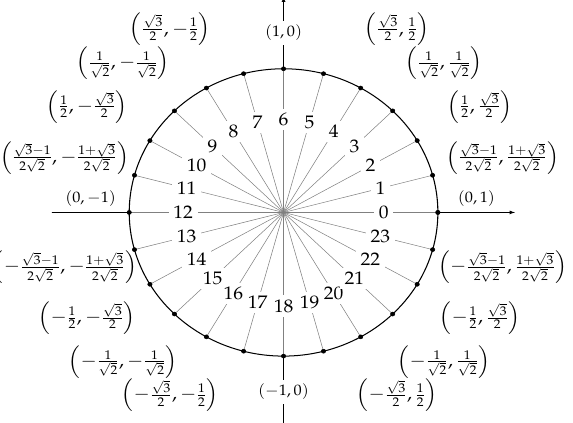
Figure 7. Values assigned to ( sec_from _midnight _sin , sec_from_mi-dnight _cos ) after a trigonometric transformation of the sec_from_mid-night feature ranging from 0 to